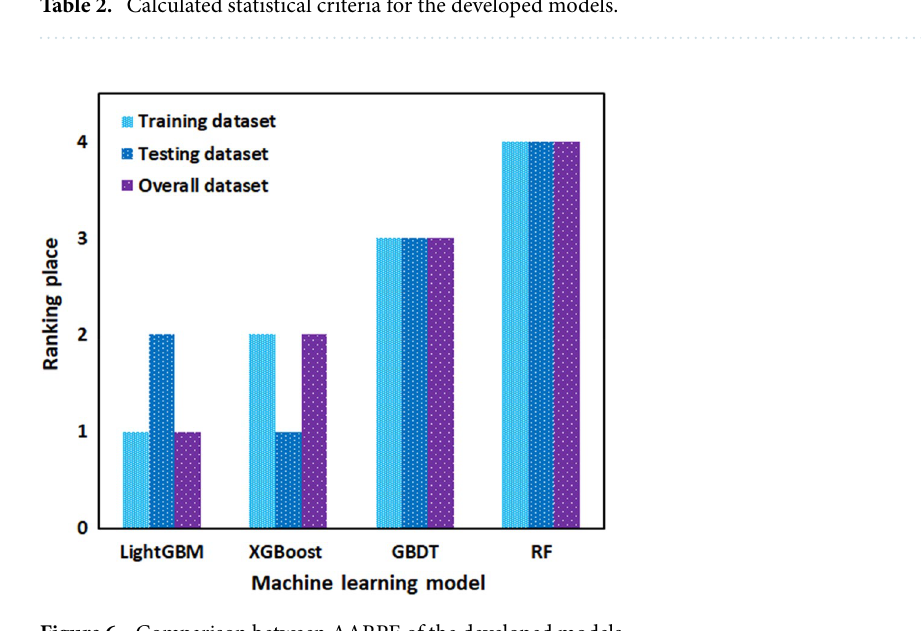
Figure 6. Comparison between AARPE of the developed